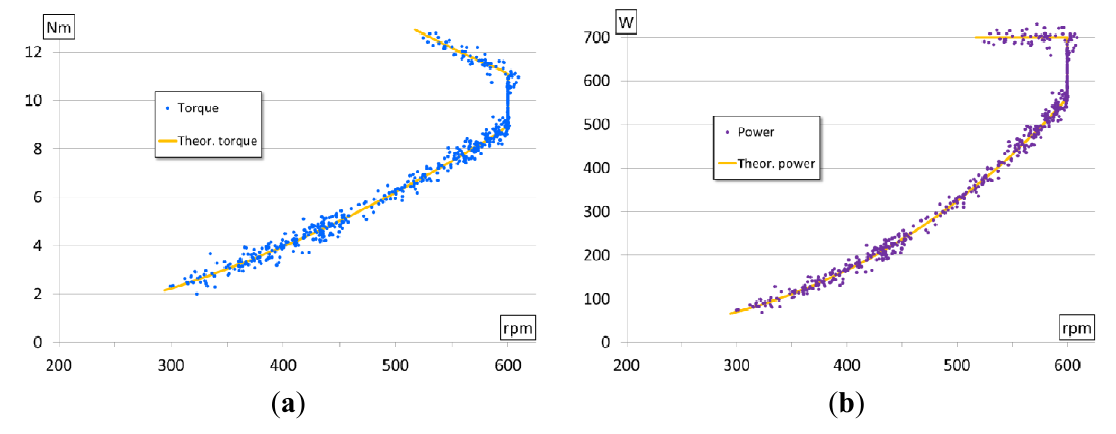
Figure 10. ( a ) Turbine torque as a function of the rotational speed; ( b ) Generated power as a function of the rotational speed of the turbine.